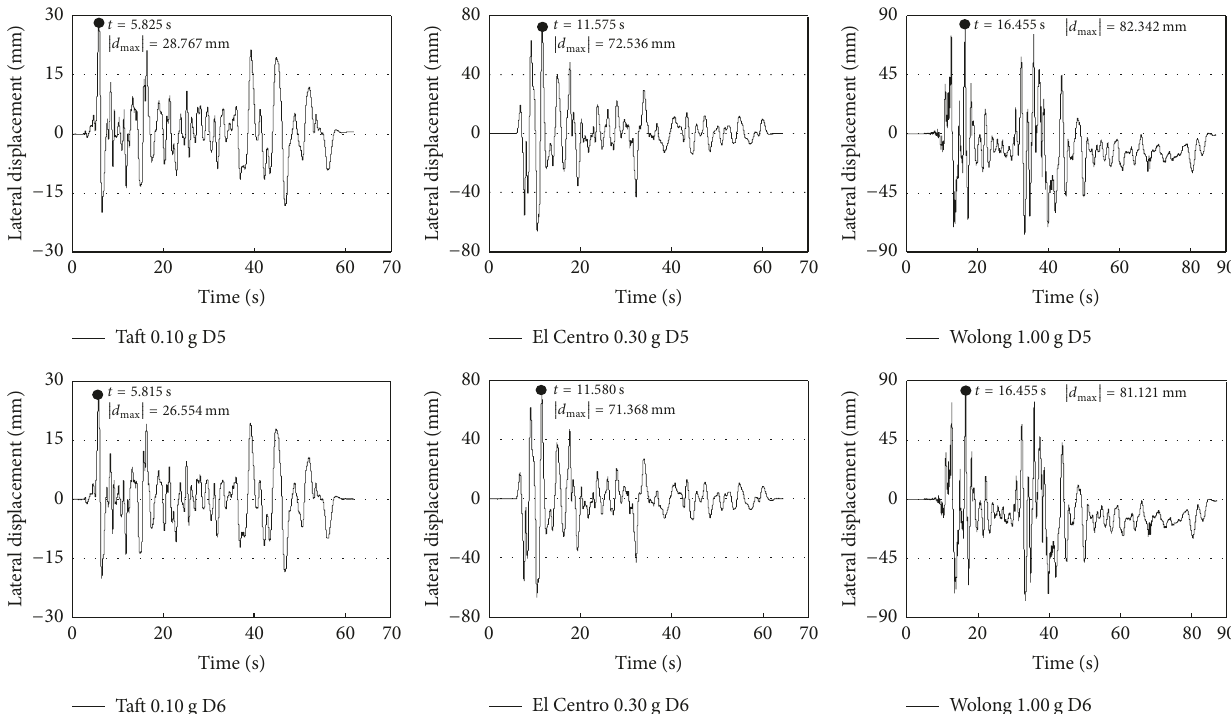
Figure 15: Displacement time histories of structural response at the frame beam and the top of infill wall under different input motions (unit: mm).